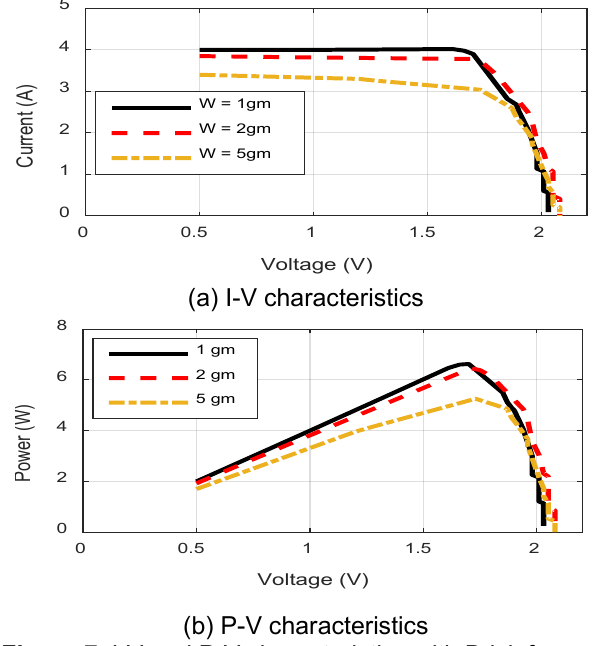
Figure 7. I-V and P-V characteristics with Brick furnace dust at 500 W/m